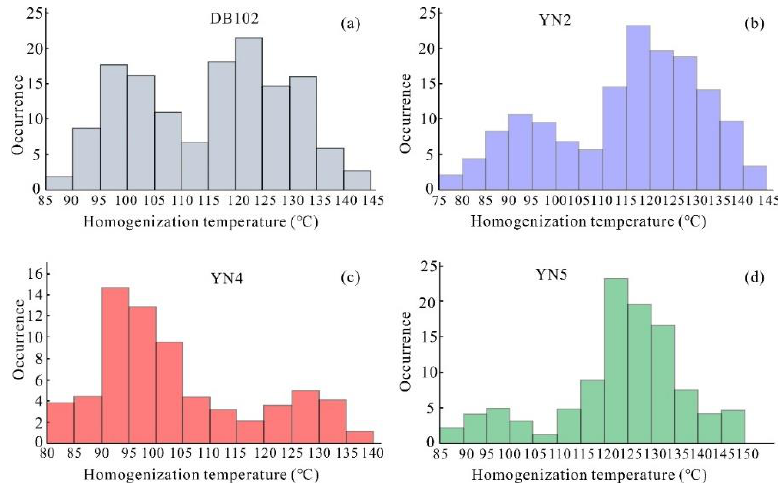
Figure 10. Homogenization temperatures of aqueous inclusions coeval with hydrocarbon inclusions in the Dibei area. ( a – d ) Homogenization temperatures for DB102 well, YN2 well, YN4 well, and YN5 well, respectively.